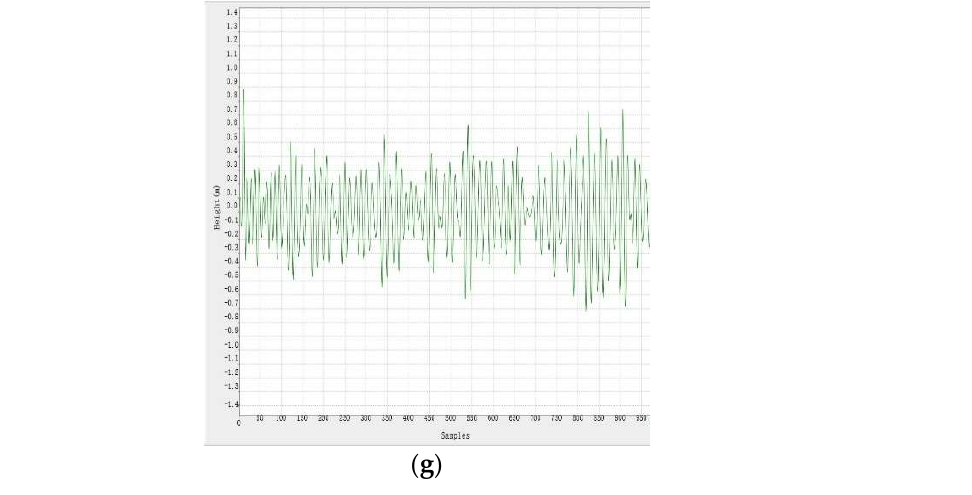
Figure 11. Illustration: ( a ) at 14:00 with stereo vision, variation in coordinate (0, 0) of sea surface displacement with time; ( b ) at 15:00 with stereo vision, variation in coordinate (0, 0) of sea surface displacement with time; ( c ) at 16:00 with stereo vision, variation in coordinate ( − 320, 0) of sea surface displacement with time; ( d ) at 16:00 with stereo vision, variation in coordinate (0, 0) of sea surface displacement with time; ( e ) at 14:00 with RBR wave high meter of sea surface displacement with time; ( f ) at 15:00 with RBR wave high meter of sea surface displacement with time; ( g ) at 16:00 with RBR wave high meter of sea surface displacement with time. The calculation results are shown in Table 6: Table 6. Measurement accuracy